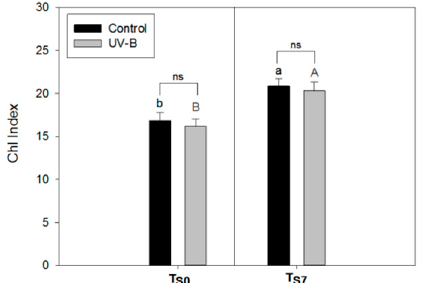
Figure 3. Chl Index of leaves of O. basilicum plants cultivated under white light (control—black bars) and supplemental UV-B radiation (UV-B—gray bars) extracted immediately at the end of the light treatment (before storage T S0 ) or after seven days of storage (T S7 ). Mean ± SD ( n = 3). Letters show the comparison between di ff erent storage times (T S0 or T S7 ) under the same light conditions (uppercase gray letters—UV-B treatment; lowercase black letters—control). Di ff erent letters indicate significant di ff erences between the values ( p < 0.05), while asterisks show the significant di ff erences between light treatments at the same time of storage; ns = not significant.